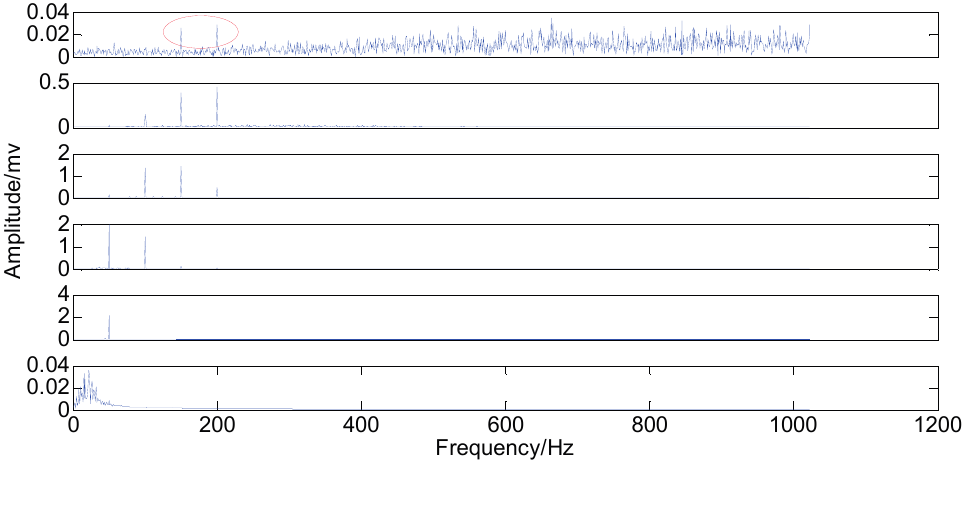
Figure 7. Original IMFs in the frequency-domain.